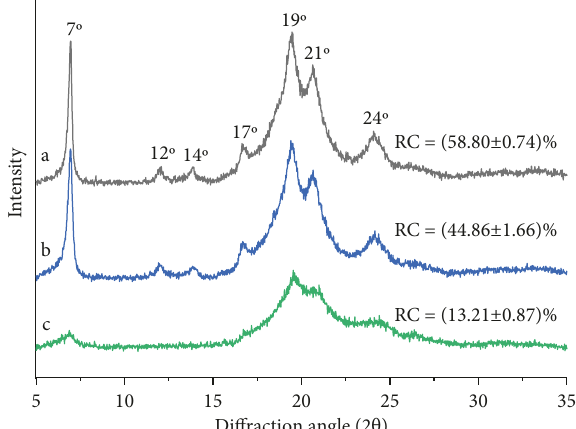
Figure 3: XRD diffraction diagrams of EGP and its